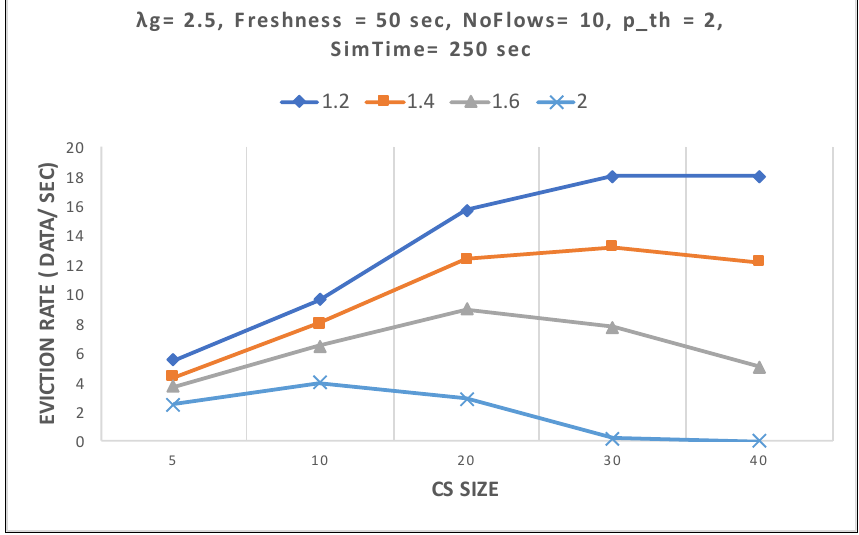
Figure 9. Eviction rate for different popularity rates and cache sizes.